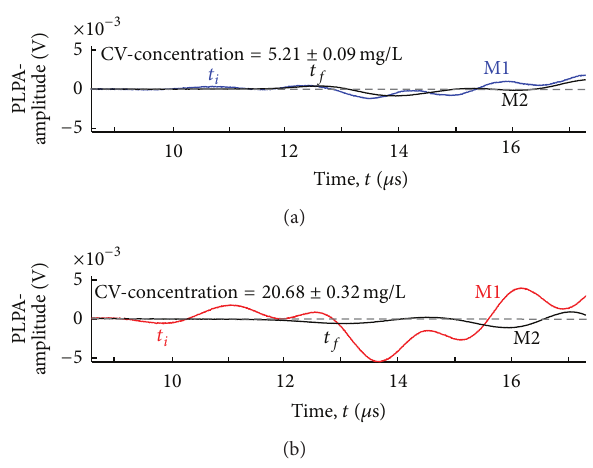
Figure 3: Representative averaged (200 data samples) PLPA-signals obtained from the M1 and M2 microphones in the GC/CV/H 2 O sys- tem at different experimental conditions: (a) PLPA-signals recorded for a low CV-loaded sample and (b) PLPA-signal measured for a highly CV-loaded liquid sample.